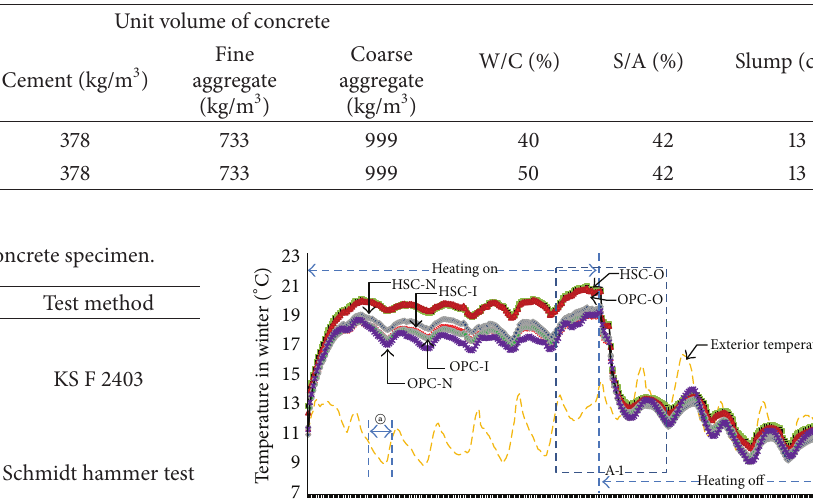
Table 3: Details about concrete specimen by mixing ratio.